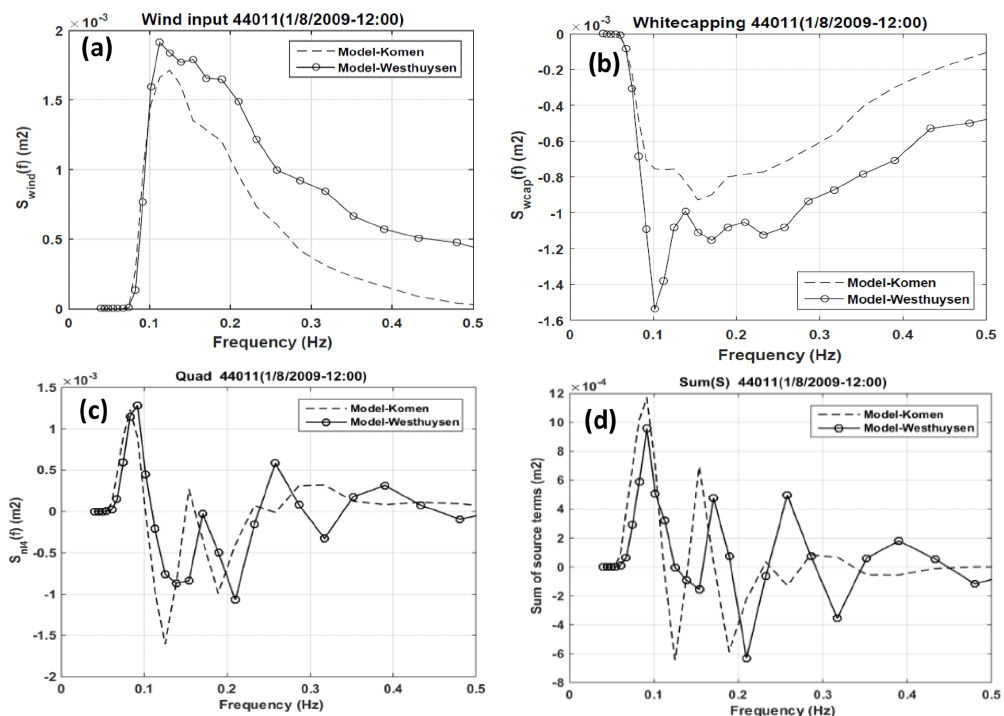
Figure 12. Variations of simulated source term components with frequency at buoy 44011 for t1: (a) wind input, (b) whitecapping dissipa- tion, (c) quadruplet, and (d) algebraic sum of these